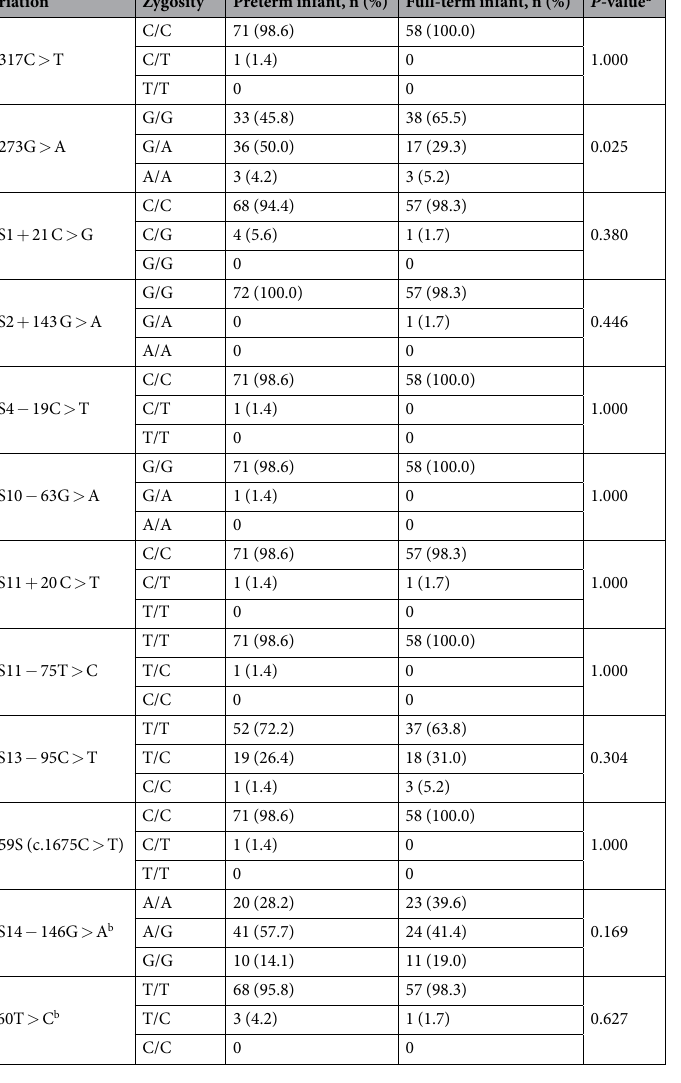
Table 3. Comparison of SHP-2 genetic variations between preterm and full-term infants. a The P- values were obtained using dominant model. b The genotype data could not be obtained in a preterm infant because of a sequencing